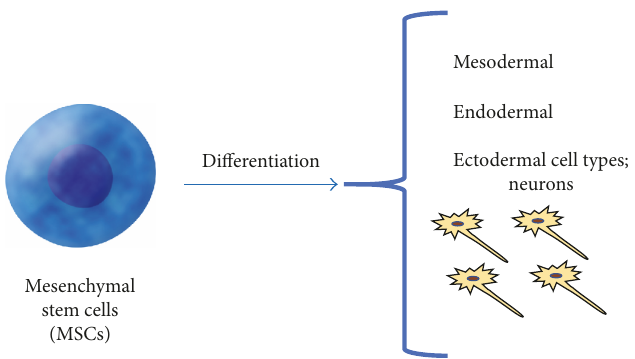
Figure 5: This fi gure demonstrates the di ff erentiation capacities of mesenchymal stem cells. They are multipotent cells and can di ff erentiate into mesodermal, endodermal, and ectodermal cell types. This includes the ability to become neurons, an important characteristic for the study of ischemic stroke and stem